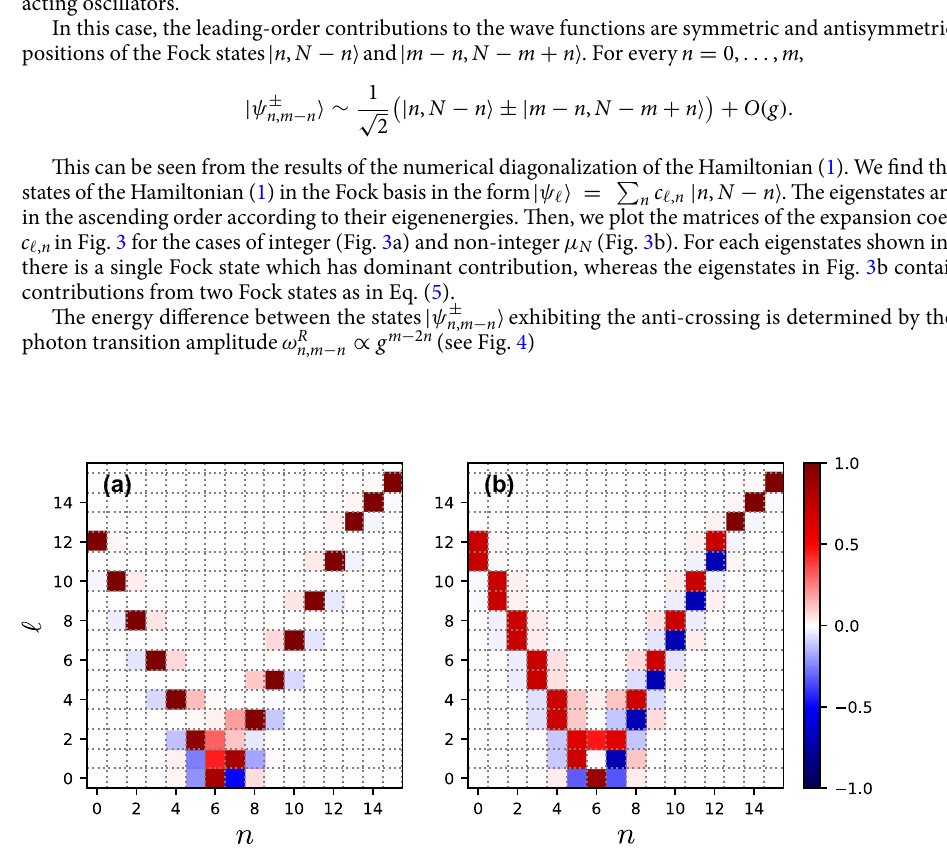
Figure 3. The expansion coefficients c ℓ , n of the eigenstates of the Hamiltonian (1) at N 0.03 , ( a ) �/α 1 6.25 and ( b ) �/α 1 6.5 are shown. For each pair n , ℓ , a unit square centered at the g /α 1 ≈ = = corresponding point of the figure is drawn. The color of the square indicates the magnitude of c n , ℓ according to the color bar.